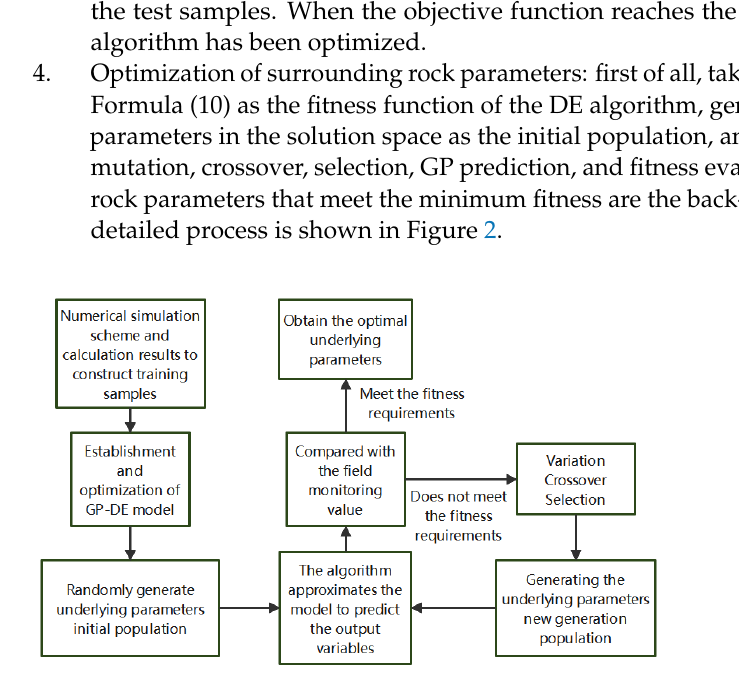
Figure 2. Flow chart of back-analysis method based on GP-DE algorithm.